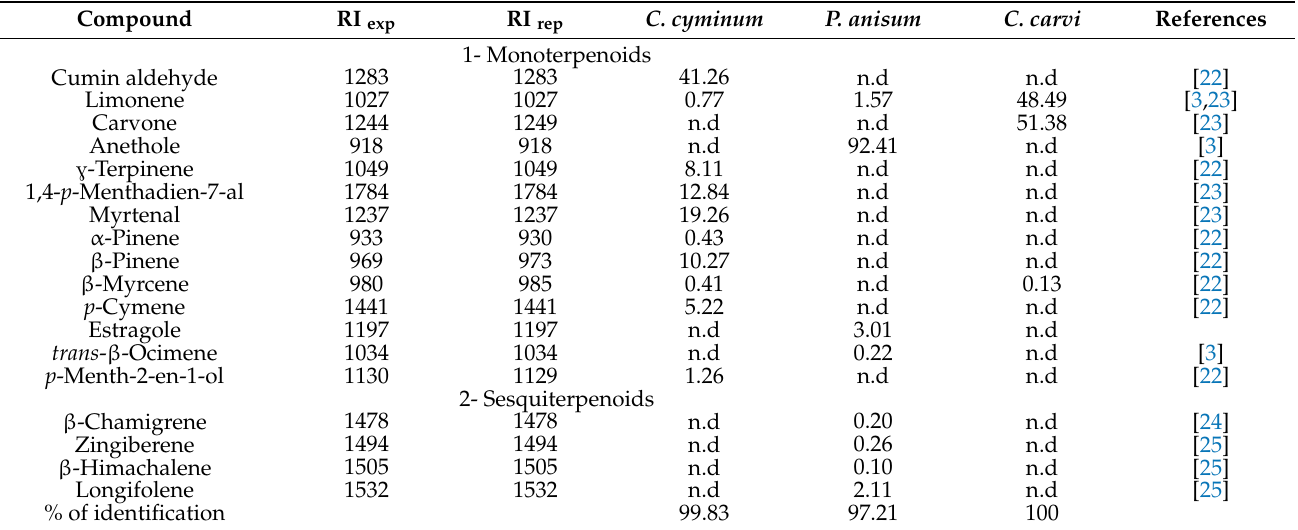
Table 1. Chemical compositions of the isolated essential oils.